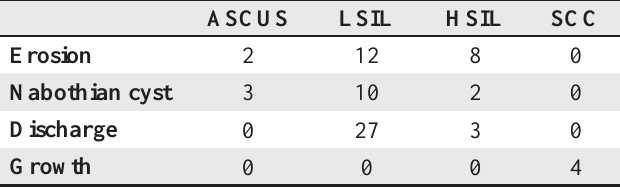
Table 4 : Findings of patients with abnormal Pap smear ASCUS LSIL HSIL SCC Erosion 2 12 8 0 Nabothian cyst 3